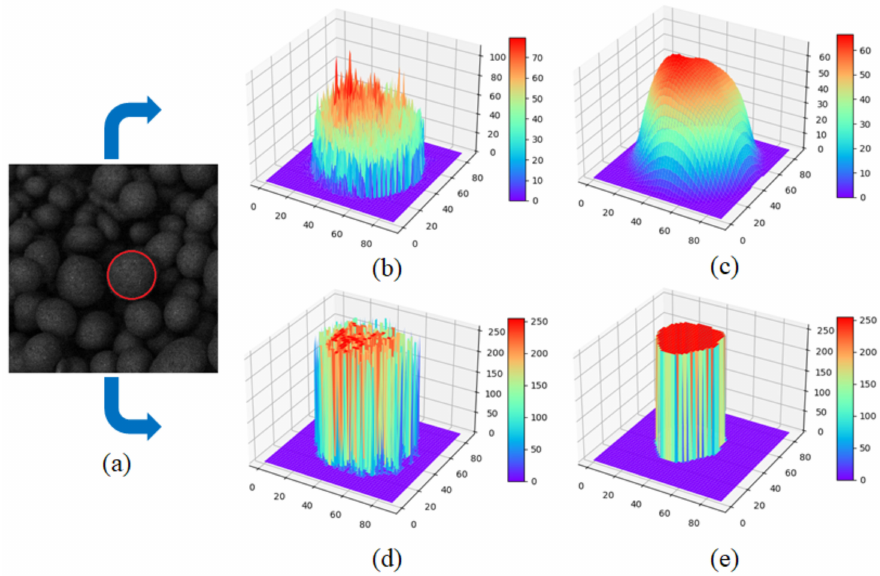
Figure 6. Gaussian reconstruction process. ( a ) The original grayscale map. ( b ) Grayscale Gaus- sian distribution of the original map. ( c ) Reconstructed map of grayscale Gaussian distribution. ( d ) Original image binarization distribution. ( e ) Reconstructed image of binarization distribution.